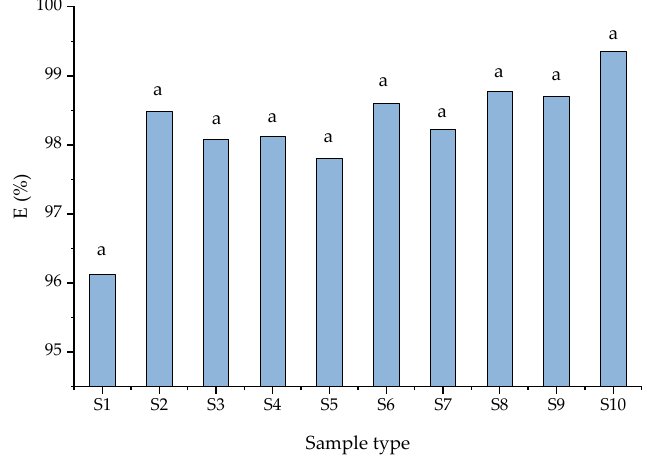
Figure 5. The removal efficiency (%) of ammonium ions depends on sample type. Data are the mean ± standard deviation ( n = 3) and the same letters show no significant difference ( p > 0.05).